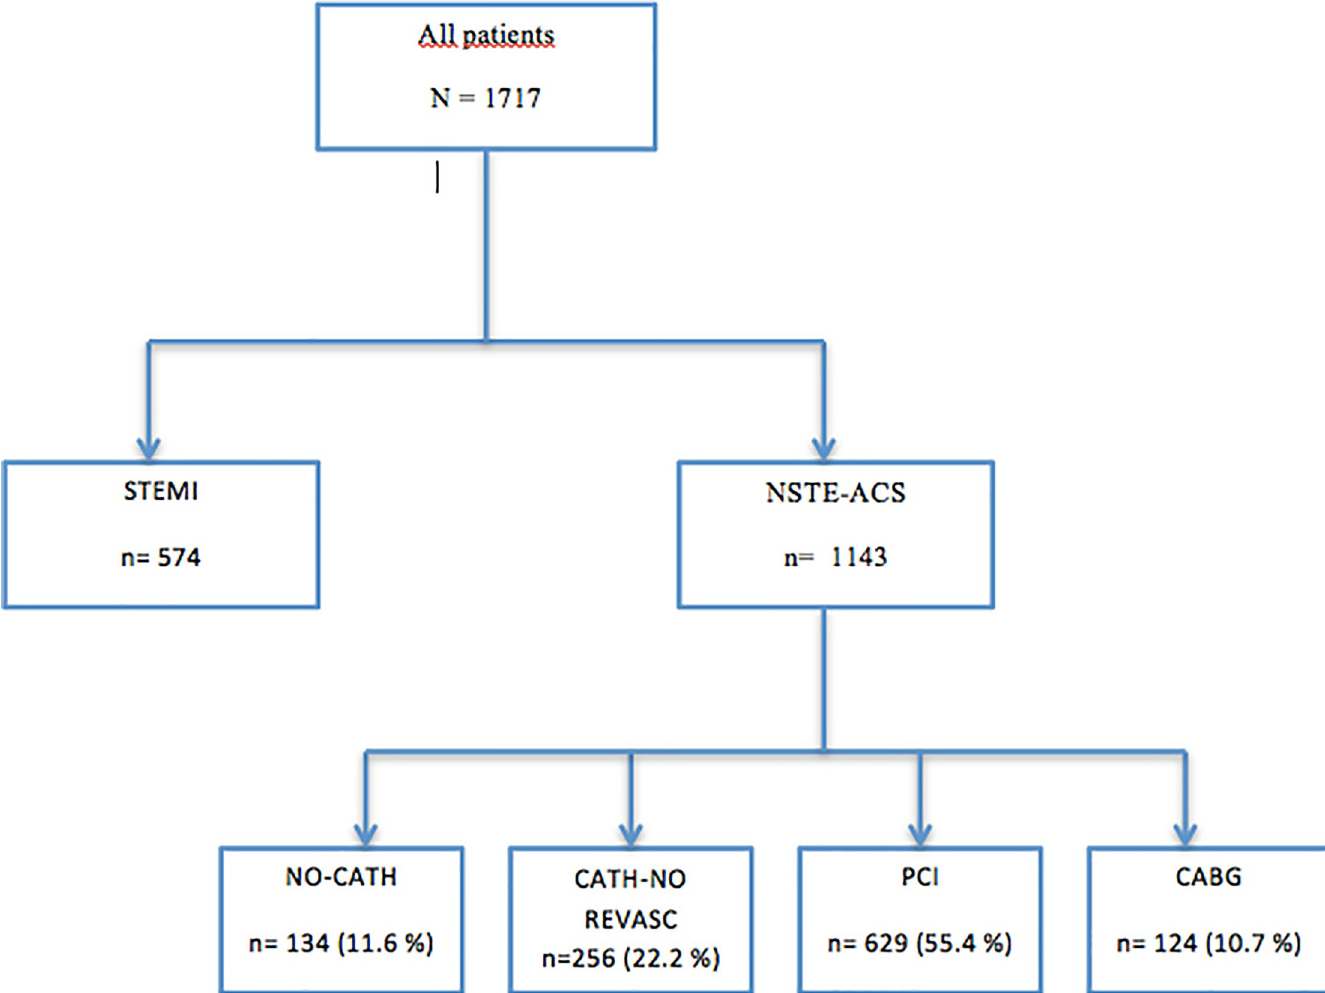
Fig 1. Flow chart of patients and analyzed subgroups. STEMI: ST-elevation myocardial infarction; NSTE-ACS: non-ST-elevation ACS; PCI: percutaneous coronary intervention; CABG: coronary artery bypass graft.